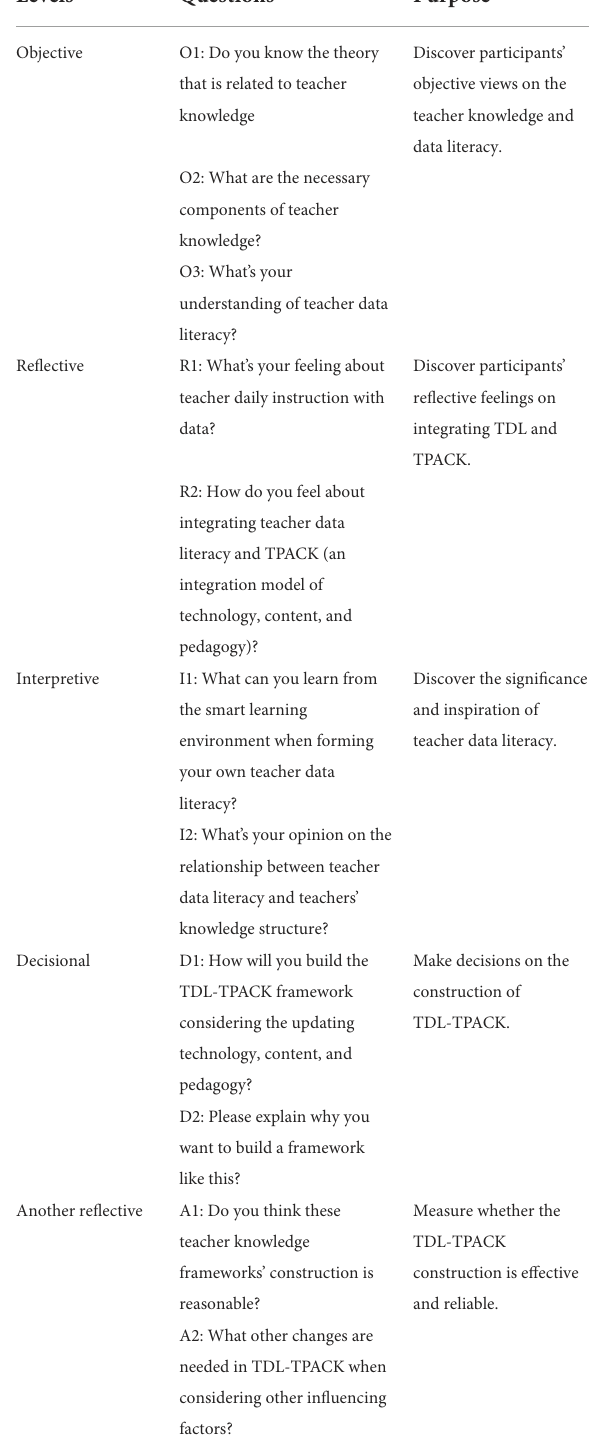
TABLE 2 Questions for